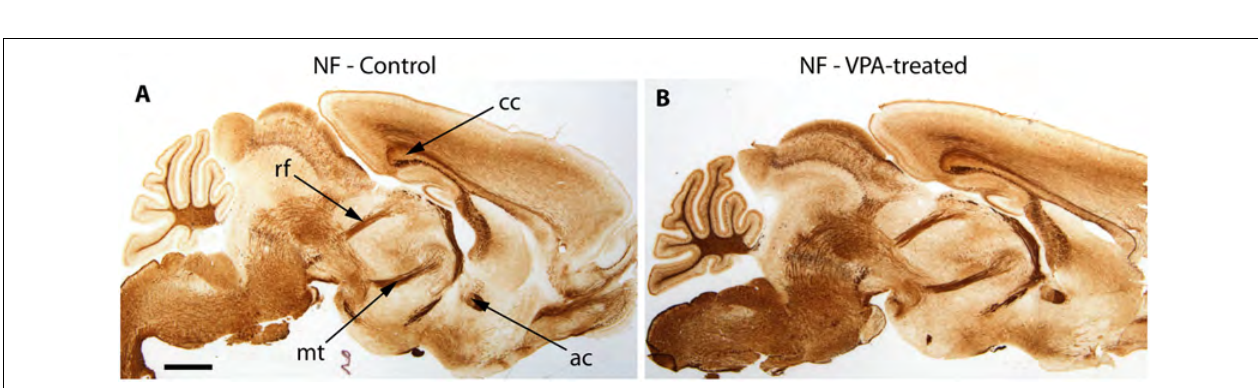
FIGURE 6 | The abundance of neuronal perikarya in the dopaminergic nuclei of the lateral hypothalamus (lateral hypothalamic/incertohypothalamic A11–13 and periventricular A12–14), SN and VTA, as revealed by volumetric analysis of TH-immunolabeled whole-mount (iDISCO) brain samples of control male and female P7 mouse pups. The graph represent the mean ± SE, n = 7 (male), n = 5 (female); ∗∗∗ p < 0.001.